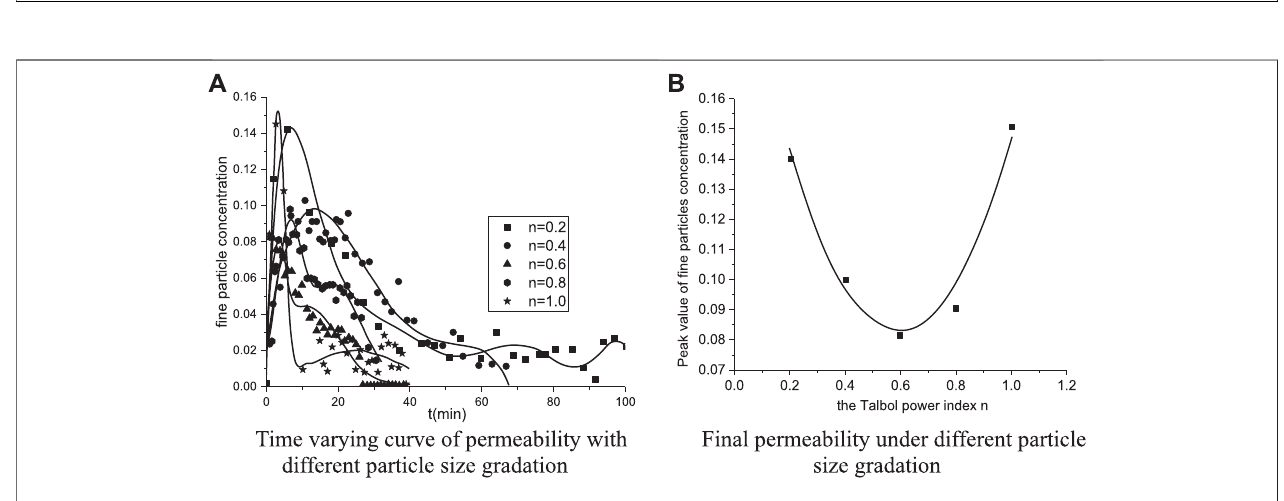
FIGURE 7 | In fl uence of particle size gradation on the evolution of the fi ne particle concentration: (A) time-varying curve of permeability with different particle size gradations and (B) fi nal permeability under different particle size gradations.